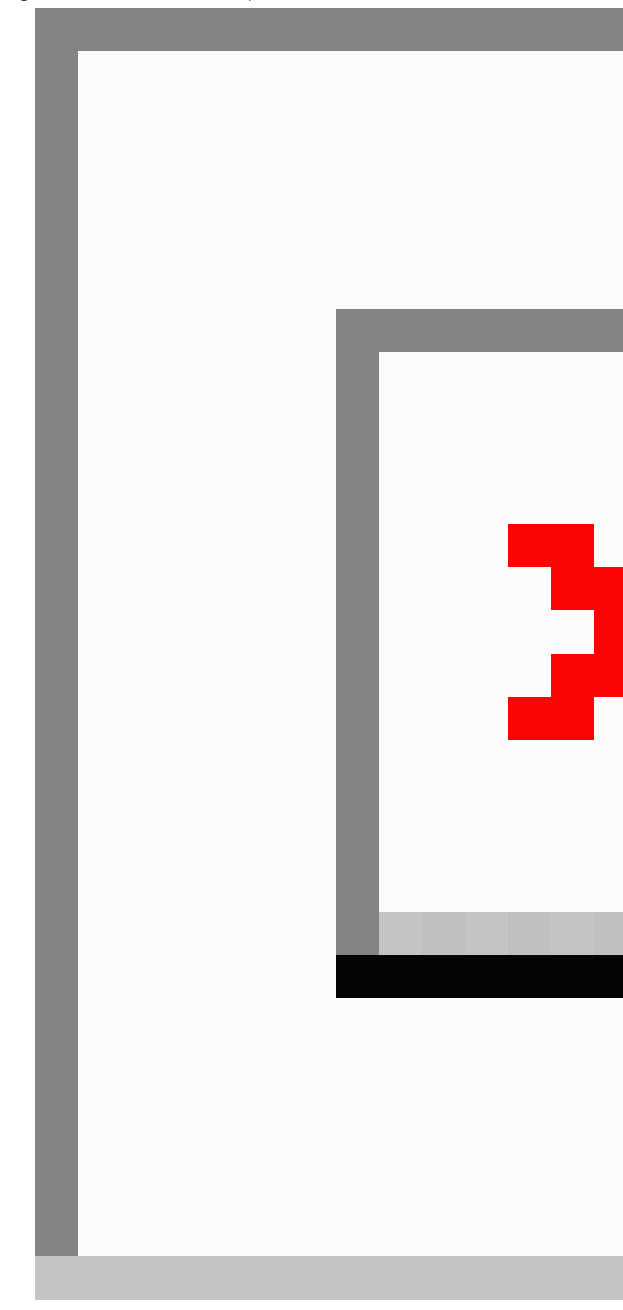
Figure 1. Screenshot of sample tailored